Question: What form of chart is displayed?
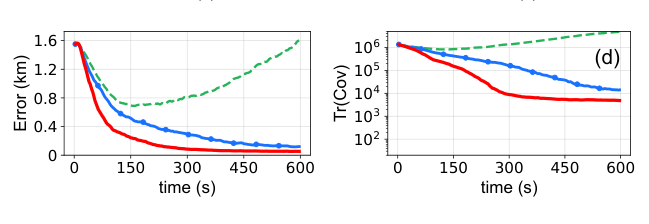
Answer: line